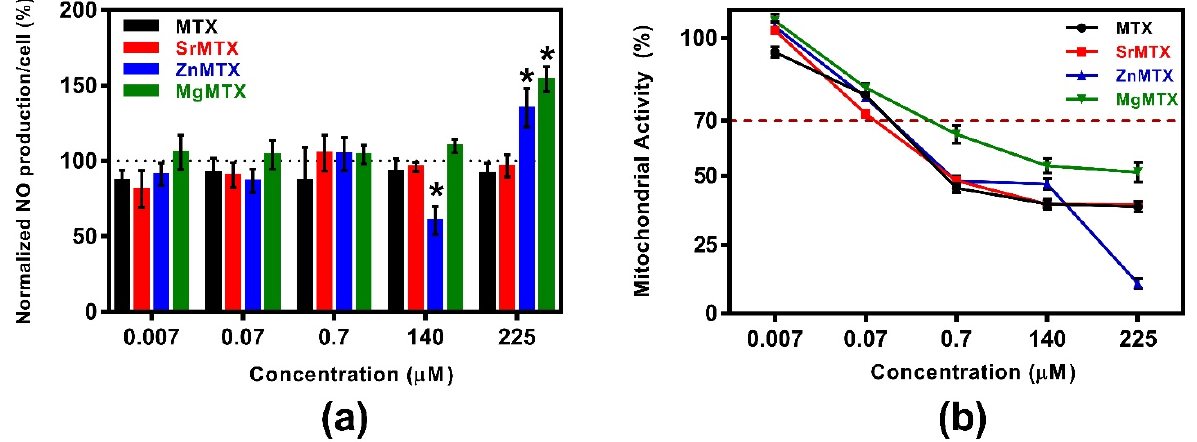
Figure 7. Additional anti-inflammatory properties of MTX and its derivatives: ( a ) Ratio of normalized NO production divided by the mitochondrial activity of non-LPS-stimulated RAW264.7 macrophage cultures; ( b ) Mitochondrial activity of non-LPS-stimulated RAW264.7 macrophage cultures. Mean values, standard deviation (n = 8), and the one-way ANOVA results comparing each condition with control cultures stimulated with LPS (100%) at a significance level of * p < 0.05 are included. As shown in Figure 7a, neither MTX nor SrMTX reduced the release of NO by RAW264.7 macrophages at any assayed concentration. Only the dose of 140 μ M ZnMTX was shown to decrease the release of NO by this cell type, while doses of 225 μ M ZnMTX and MgMTX increased this parameter.